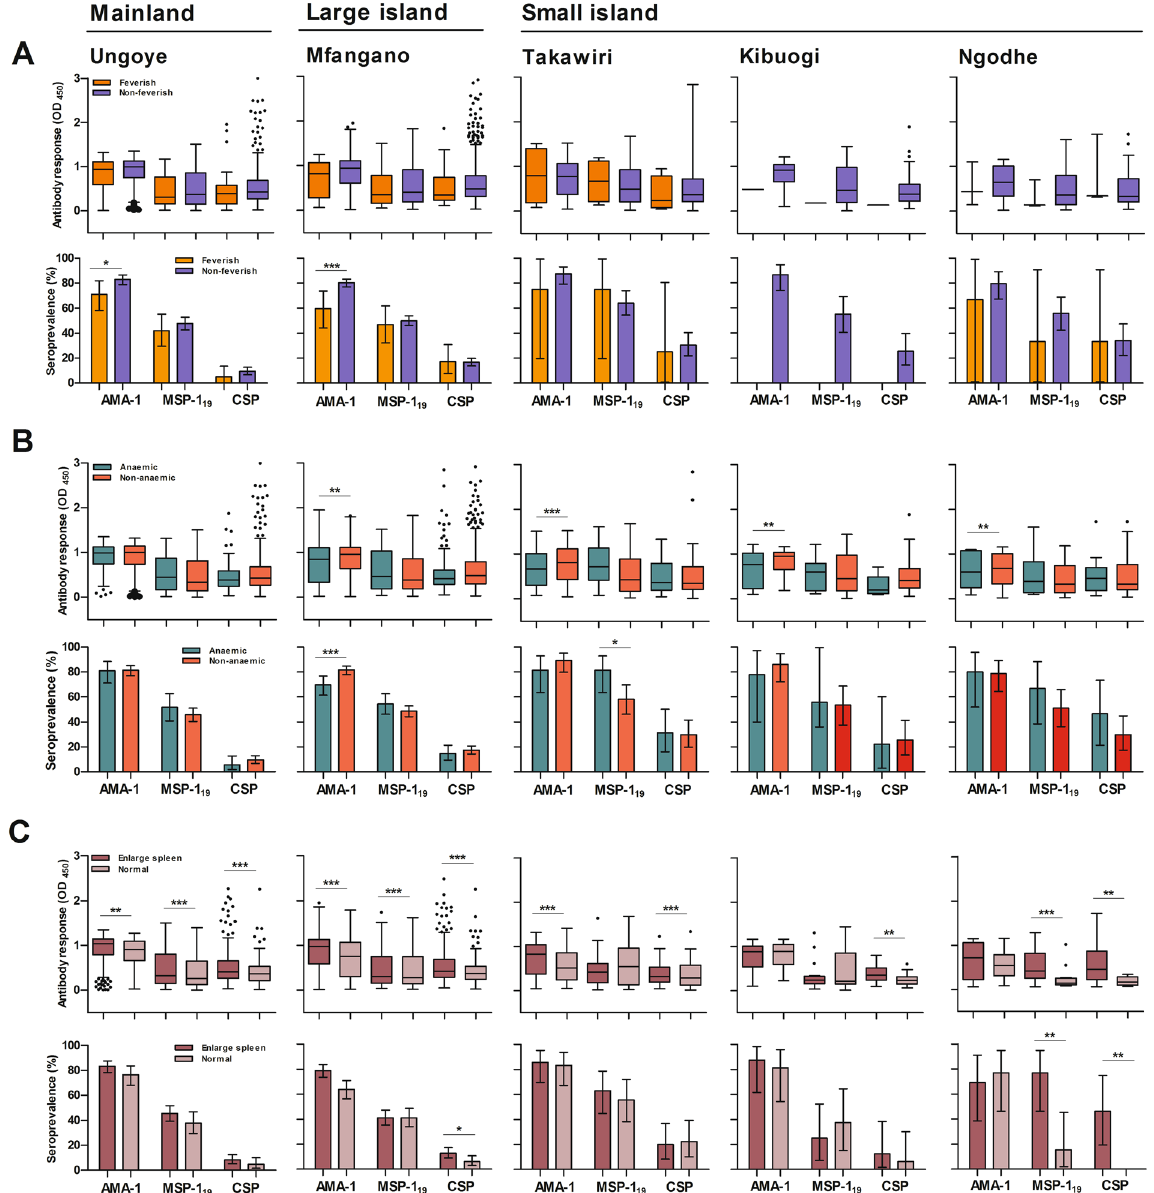
Figure 5. Age-adjusted antibody responses among P . falciparum infected individual (positive by PCR) for AMA-1, MSP-1 19 and CSP in each setting. ( A ) Presented with or without fever; stratified into non-febrile (axillary temperature ≤ 37.5 °C) and febrile ( > 37.5 °C) groups. ( B ) Presented with or without anaemia; stratified into anaemic (Hb level < 11 g/dL) and non-anaemic (Hb level ≥ 11 g/dL) groups. ( C ) Presented with or without enlarged spleen among children ≤ 12 years old by Hackett’s method; stratified into enlarged spleen and normal groups. Data are presented in box plots (with the median shown as a line within the box and interquartile value (IQR, 25th–75th percentile) at the edge of box) and bar graphs (with Error bar represents 95% confidence interval (CI)). Any outlier values exceeding the interquartile range are shown as circles. Differences between the two groups of antibody levels were analysed by linear regression adjusting values for age (antibody level) and Chi-square test (proportion). * , ** and *** indicates significance at P < 0.05, P < 0.01 and P < 0.001,